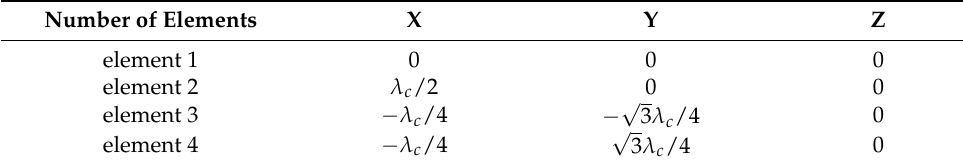
Table 2. Element positions of four-element central circular